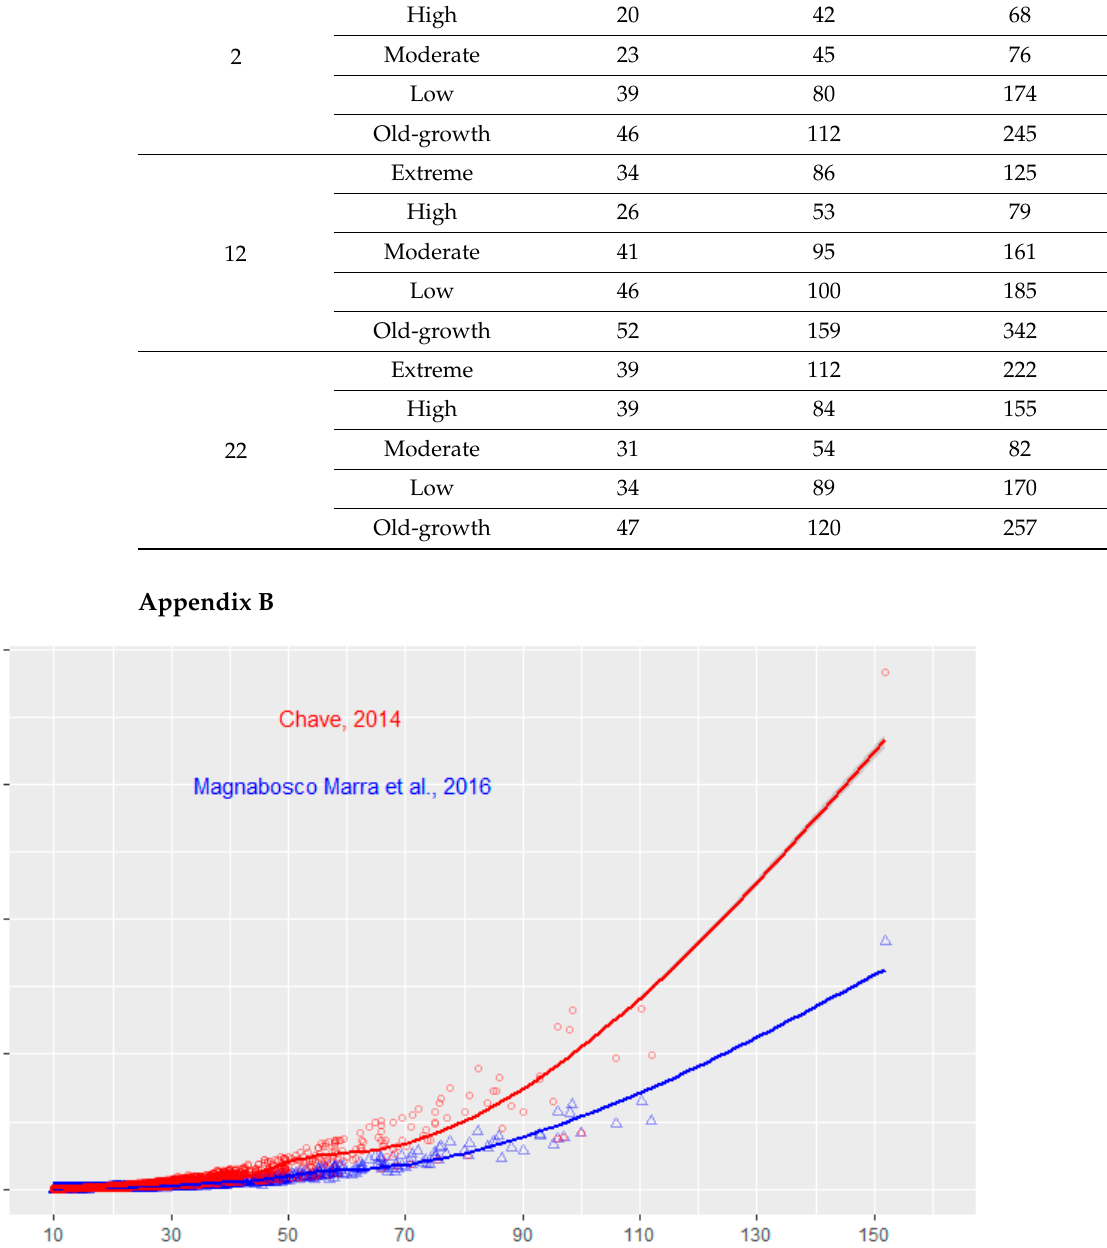
Figure A2. of old-growth and windthrown forests across the range of severity classes at 2, 12, and 22 years after wind- throw. 95% confidence intervals given by the error bars. Dashed dark green lines show the old-growth mean (of the three sites).